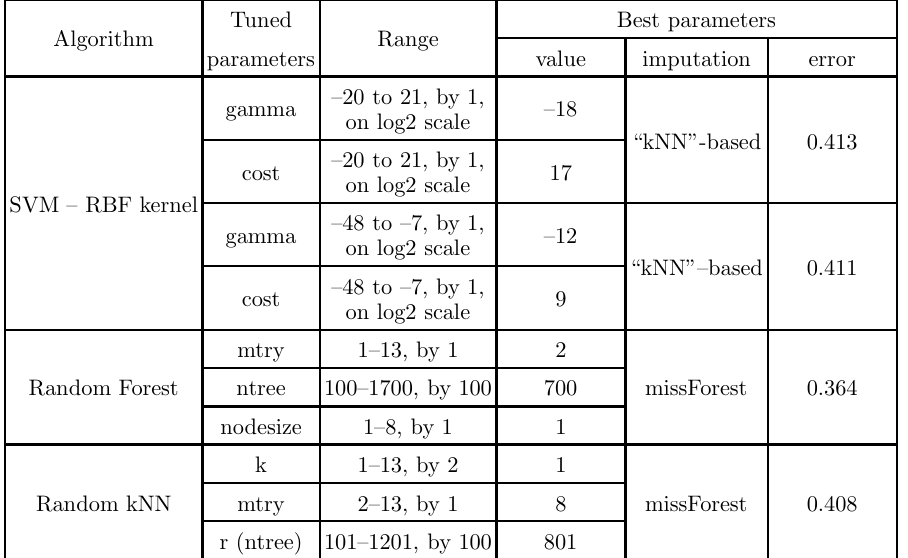
Table 5. Tuned parameter ranges and results for classification